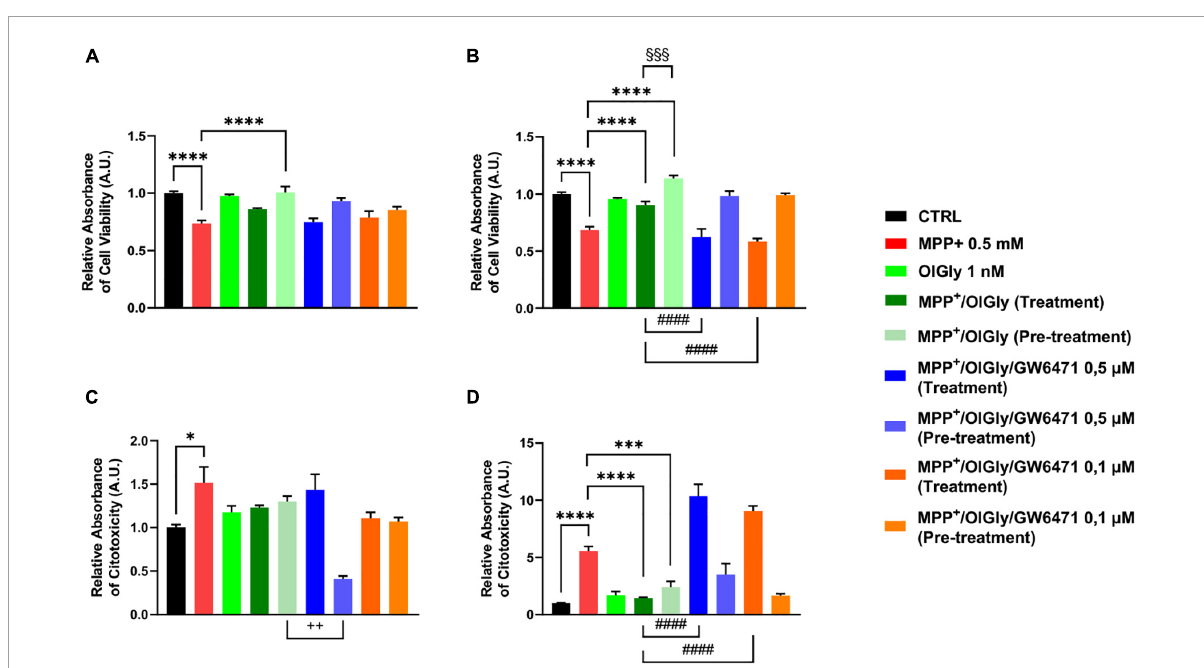
FIGURE4 Cell viability (A,B) and cytotoxicity (C,D) in (A,C) not-differentiated and (B,D) differentiated SH-SY5Y cells measured with the ApoTox-Glo triplex assay. Histograms represent the percentage, with respect to control cells (CTRL, 100%), of viable cells (A,B) or dead cells (C,D) after the exposure to MPP + (0.5 mM), OlGly (1 nM), and GW 6471 (0.5 and 0.1 µ M) in both simultaneous treatment and pre-treatment experiments. Data are represented as mean ± SEM. ∗ Indicates values statistically significant vs. MPP + ; # indicates values statistically significant vs. MPP + / OlGly (simultaneous treatment); + indicates values statistically significant vs. MPP + / OlGly (pre-treatment); § indicates values statistically significant of MPP + / OlGly (simultaneous treatment) vs. MPP + / OlGly (pre-treatment). Student’s t-test was used for statistical analysis ( N = 6). ∗∗∗∗ Indicates values statistically significant with p < 0.0001; ∗∗∗ , ### , and §§§ indicates values statistically significant with p < 0.001; #### indicates values statistically significant with p < 0.0001; ++ indicates values statistically significant with p < 0.01; ∗ indicates values statistically significant with p < 0.05.